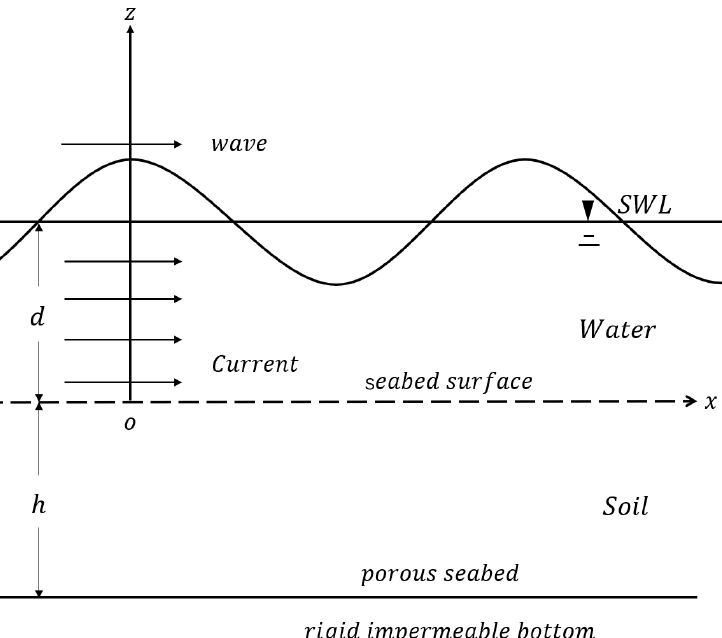
Figure 1. Sketch of wave (current)–seabed